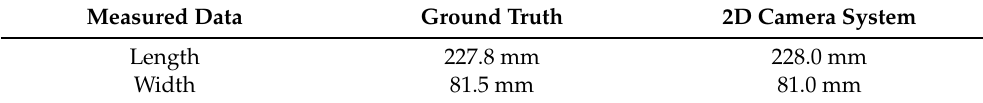
Table 1. Results of the foot measurement with the Feetbox Evo RGB camera measuring system. Measured